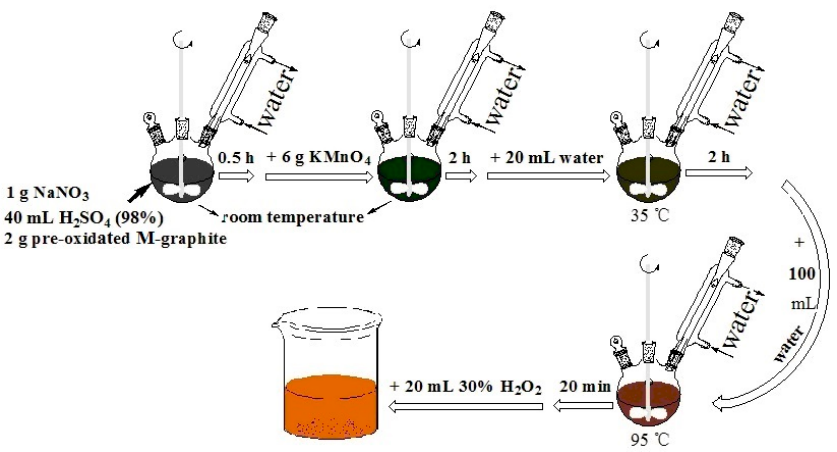
Figure 1. A process for graphene oxide production.